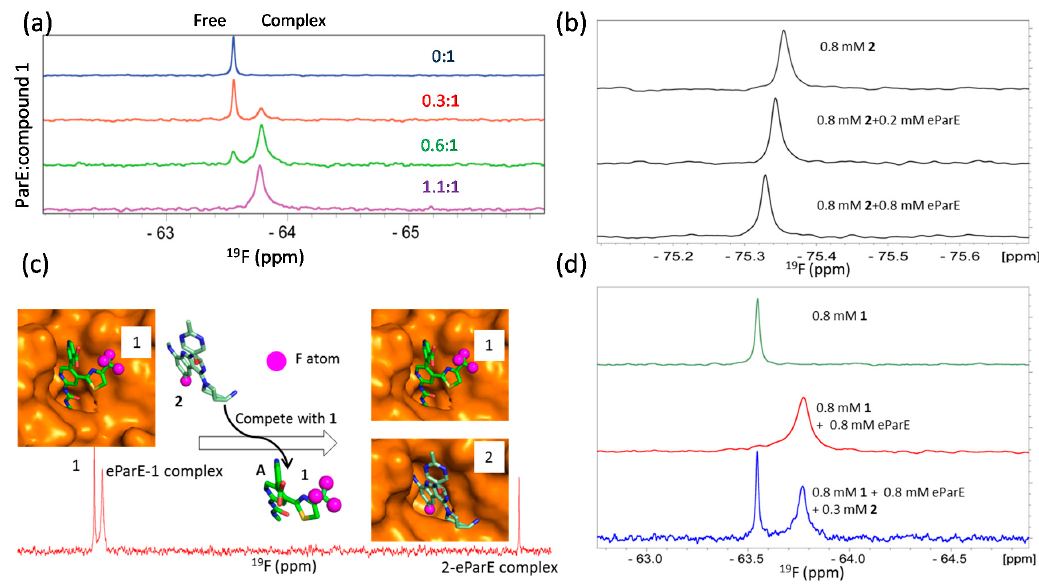
Figure 6. 19 F NMR in competition studies. ( a ) 19 F NMR of compound 1 in the presence of different amounts of eParE. Signal from free and eParE bound compound 1 can be observed and exhibit obviously different chemical shits; ( a ) is obtained from the reference [161] with slight modifications; ( b ) 19 F NMR of compound 2 in the presence of different amounts of eParE; Chemical shift perturbation is observed for compound 2 when it binds to eParE; ( c ) Compound 2 can displace compound 1 out of the binding pocket. The models of the eParE in complexes with compounds 1 and 2 are shown, respectively. 19 F atoms are labeled as purple spheres; ( d ) 19 F NMR of compound 1 in the equal molar concentration of eParE and 0.3 mM of compound 2 . Compound can be competed from eParE as resonance of free compound 1 is observed when compound 2 is present; ( b – d ) is obtained from the reference [163] with slight modifications.